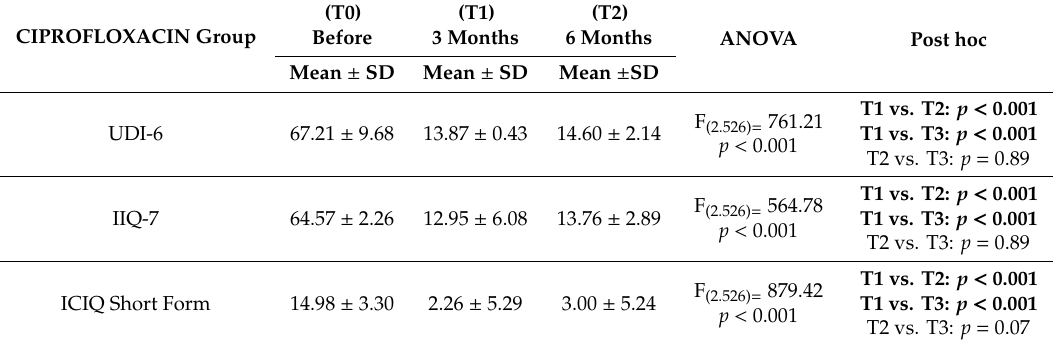
Table 3. The influence of TOT surgery on the results of ICIQ-SF, UDI-6, and IIQ-7 questionnaires in patients receiving